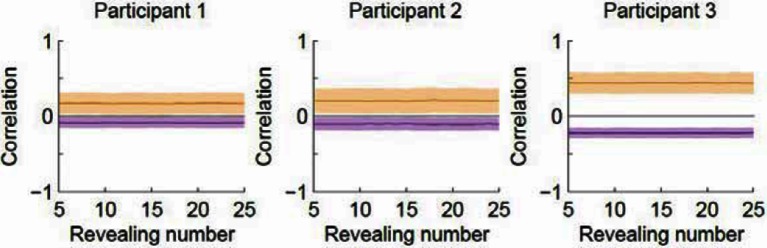
Correlation as a function of revealing number with the revealing number shuffled.Orange denotes within-type correlation; purple denotes across-type (cf. Figure 3B in the manuscript). Line and shaded area represent mean and SD, respectively.